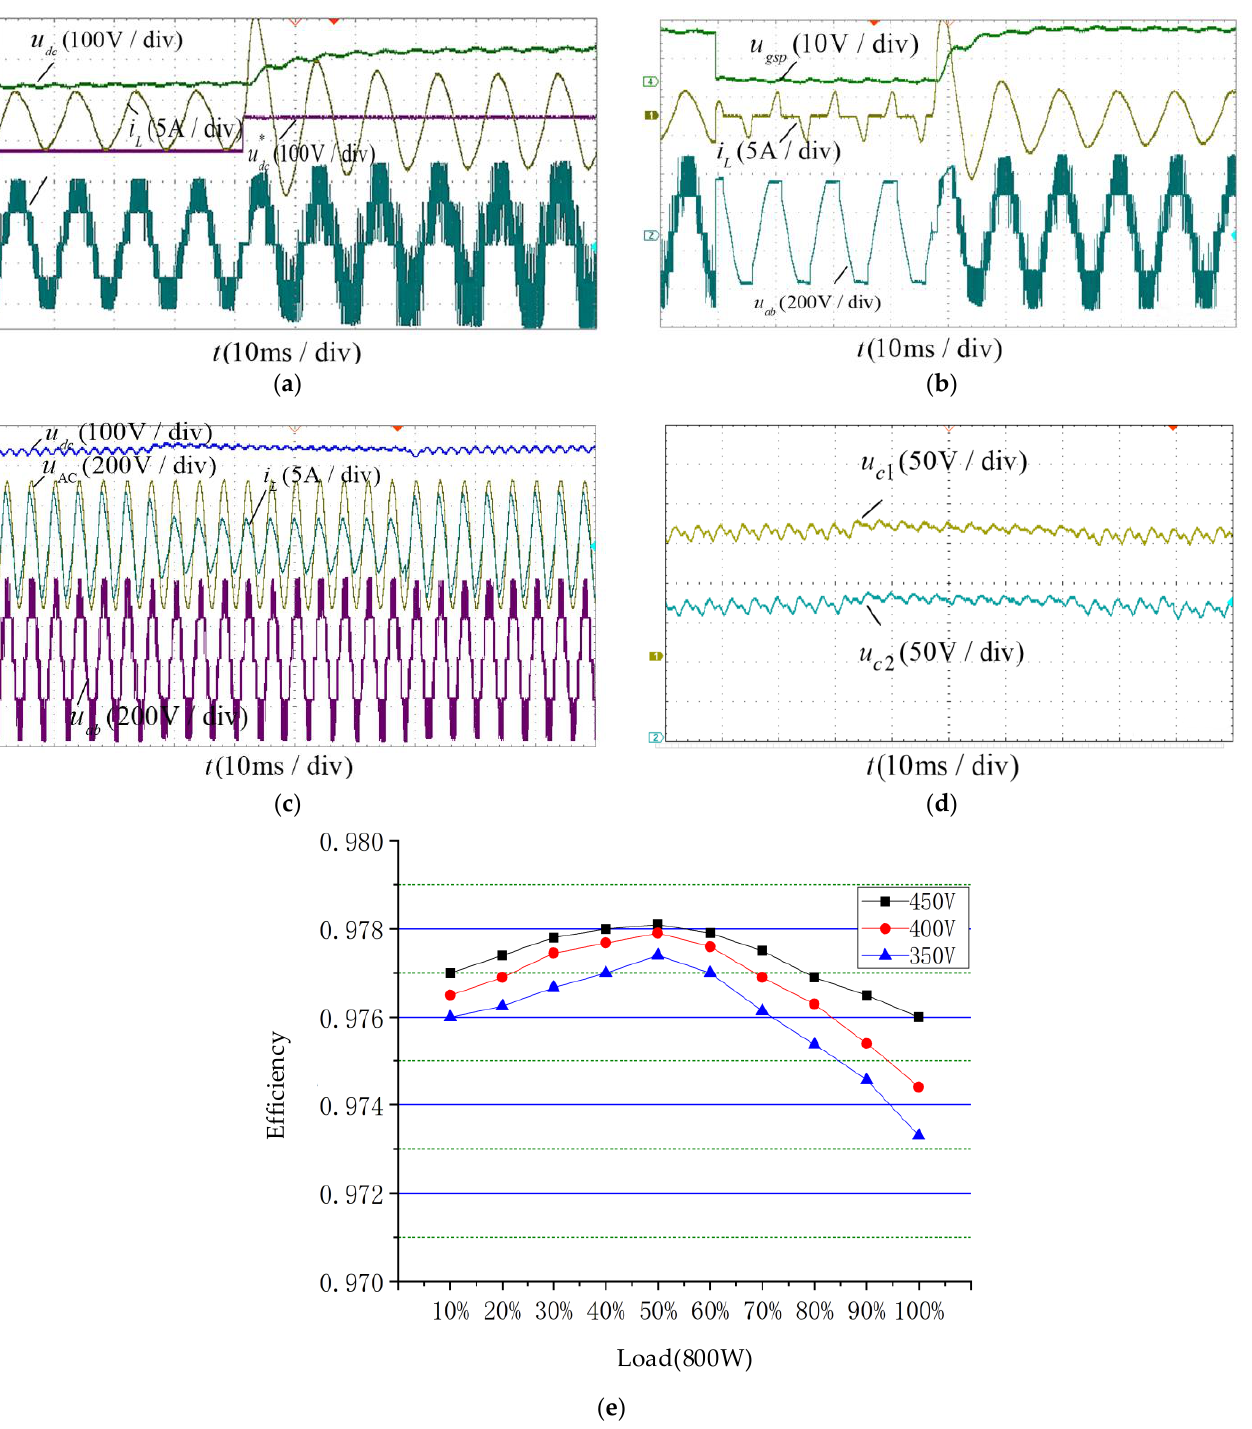
Figure 12. The experimental results in a dynamic state. ( a ) Experimental waveforms during the reference voltage increase from 400 V to 500 V. ( b ) Experimental waveforms from uncontrolled process jump to controllable process. ( c ) Experimental waveforms when the load increases or decreases by 50%. ( d ) The capacitor voltage waveforms when the load increases or decreases by 50%. ( e ) Efficiency comparison at different output voltage levels.